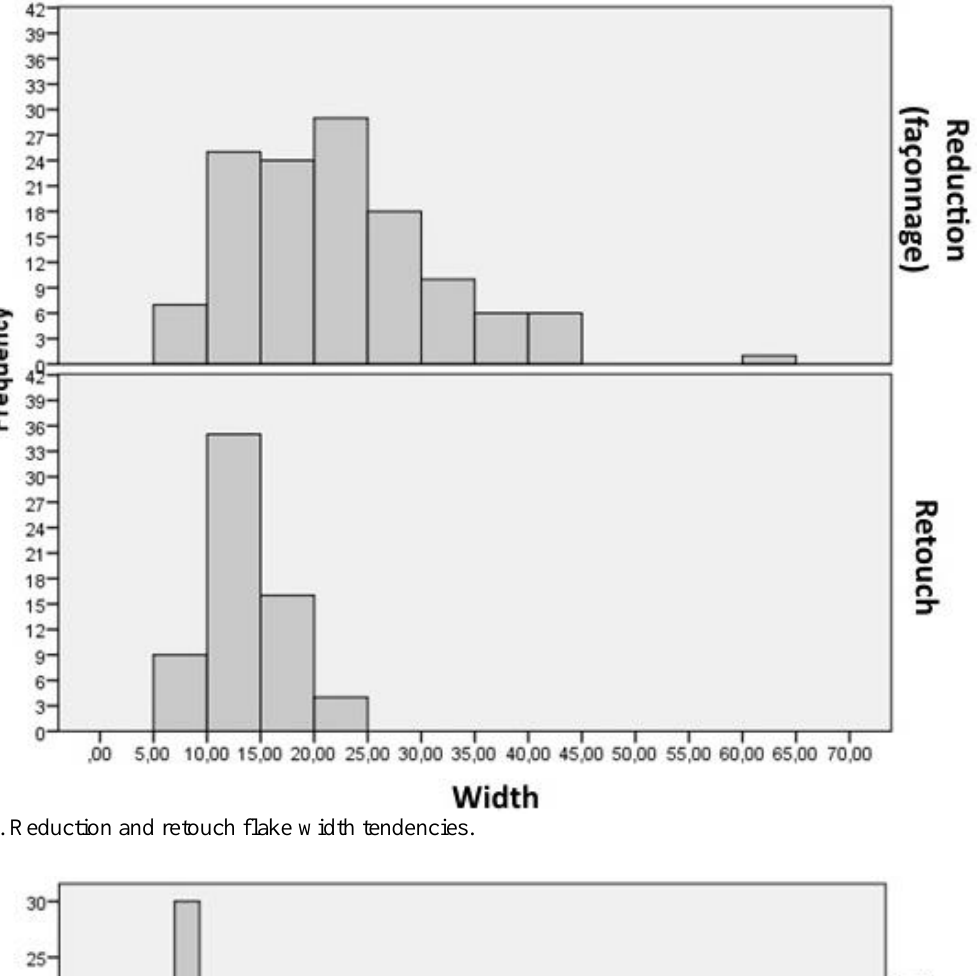
Figure 8. Reduction and retouch flake width tendencies.